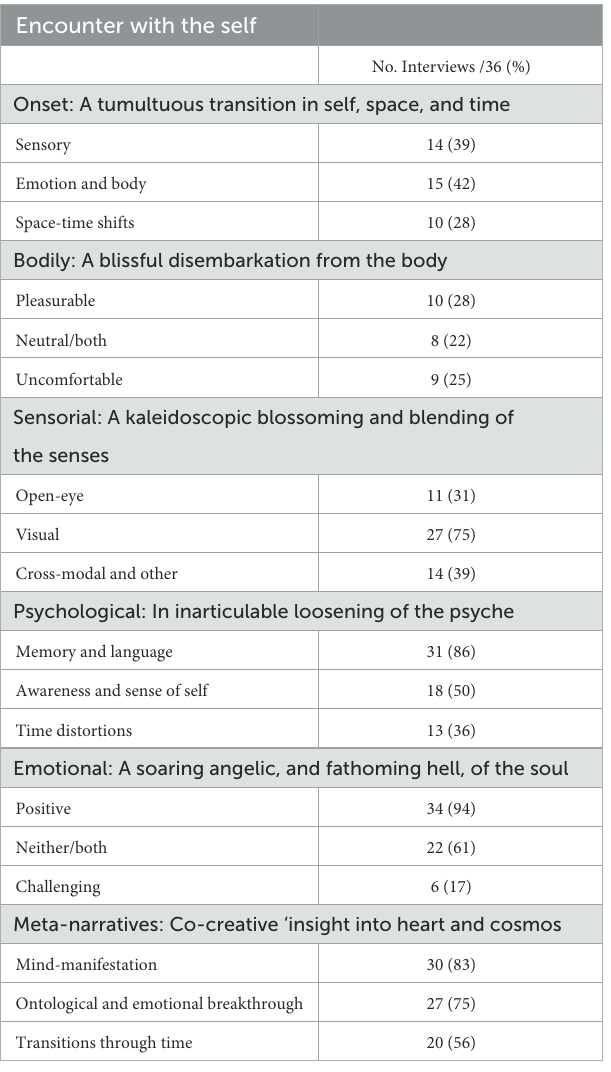
TABLE 2 Thematic analysis of the DMT experience: an encounter with the self; tabularization of categories, super-ordinate, and mid-level themes explored in the present article—see Supplementary Table 3, for a list of all